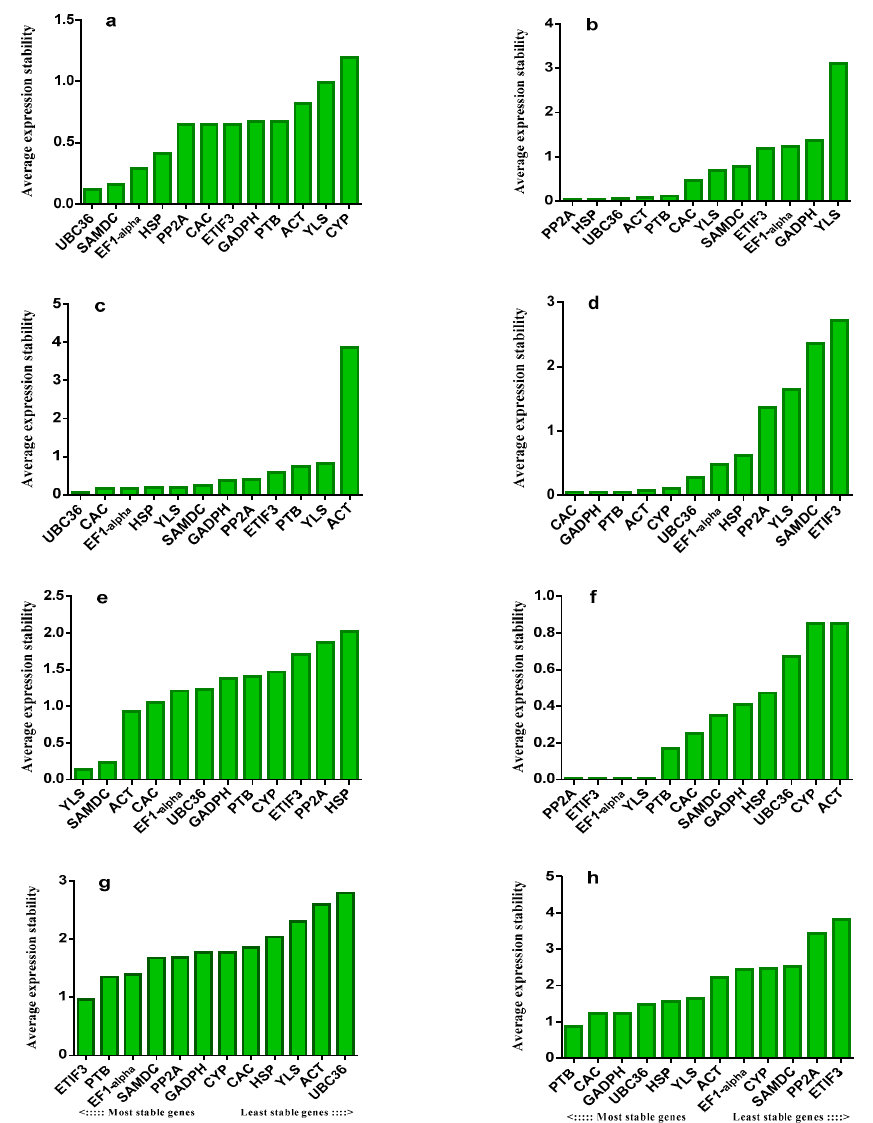
Figure 4. Average expression stability (M) calculated by NormFinder under control, abiotic stress conditions and different developmental stages in Ae. tauschii. ( a ) control, ( b ) salinity, ( c ) drought, ( d ) heat, ( e ) cold, ( f ) seedling ( g ) development and ( h ) total. ACT = actin, GAPDH = glyceraldehyde- 3-phosphate dehydrogenase, EF1-alpha = elongation factor 1 alpha, SAMDC = S-adenosylmethionine decarboxylase proenzyme, UBC36 = ubiquitin-conjugating enzyme E2 36-like, CYP = peptidyl-prolyl cis-trans isomerase CYP19-4 -like, PTB = polypyrimidine tract-binding protein homolog 1-like, CAC = intracellular transport protein, PP2A = serine/threonine protein phosphatase 2A, ETIF3 = eukaryotic translation initiation factor3, HSP = protein microrchidia 2-like, YLS = thioredoxin-like protein.